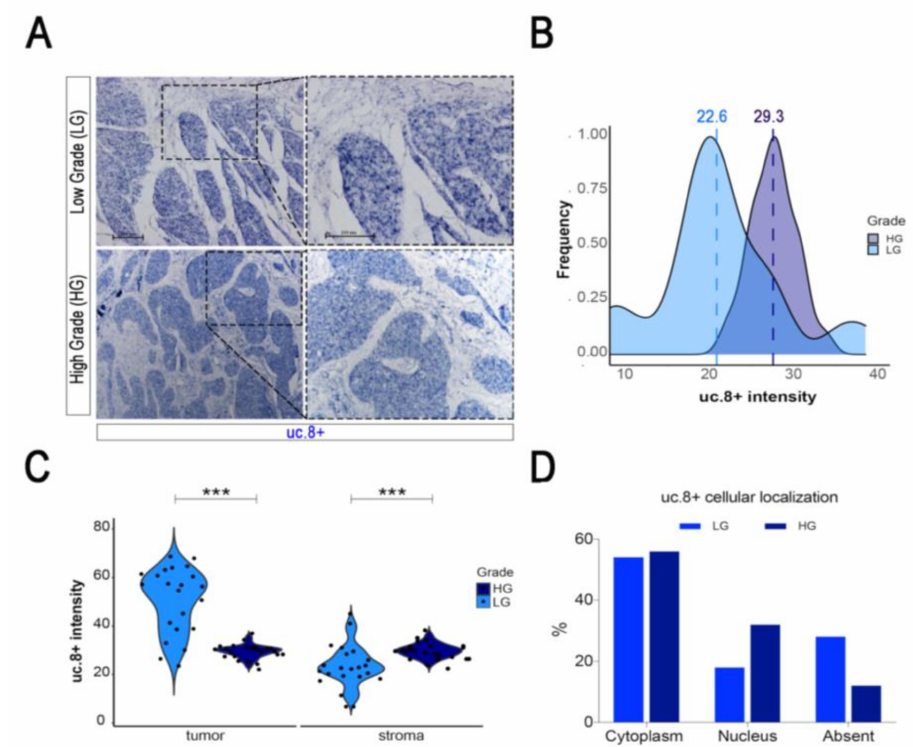
Figure 4. ( A ) Representative pictures of RNA in situ hybridization of uc. 8+ in BlCa pts-surrounding stroma. ( B ) Frequency plot showing the scaled distribution of uc.8+ intensity in bladder cancer- surrounding stroma according to the grade. ( C ) Violin plots showing uc.8+ intensity score values in tumor and surrounding stroma across tumor grade. ( D ) Bar plots showing uc.8+ cellular localization according to the grade stratification. *** p -values <